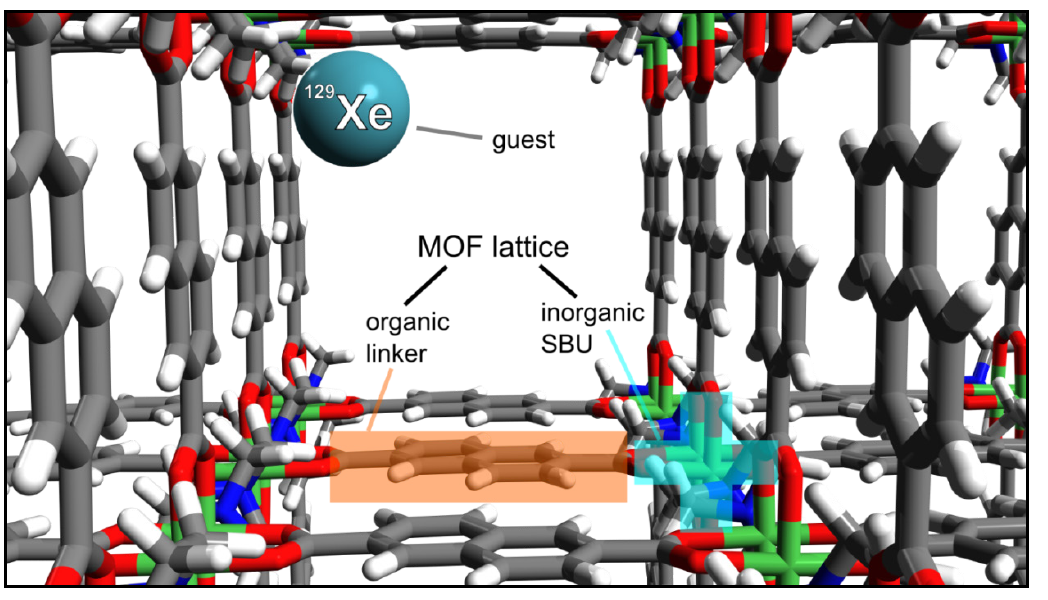
Figure 1. Schematic representation of the metal–organic frameworks (MOF lattice (here: DUT-8(Ni) [23]), consisting of organic linkers and inorganic secondary building units (SBUs). The MOF serves as a host structure for guests such as 129 Xe within the void spaces. C: grey, H: white, N: blue, O: red, Ni: green, Xe: